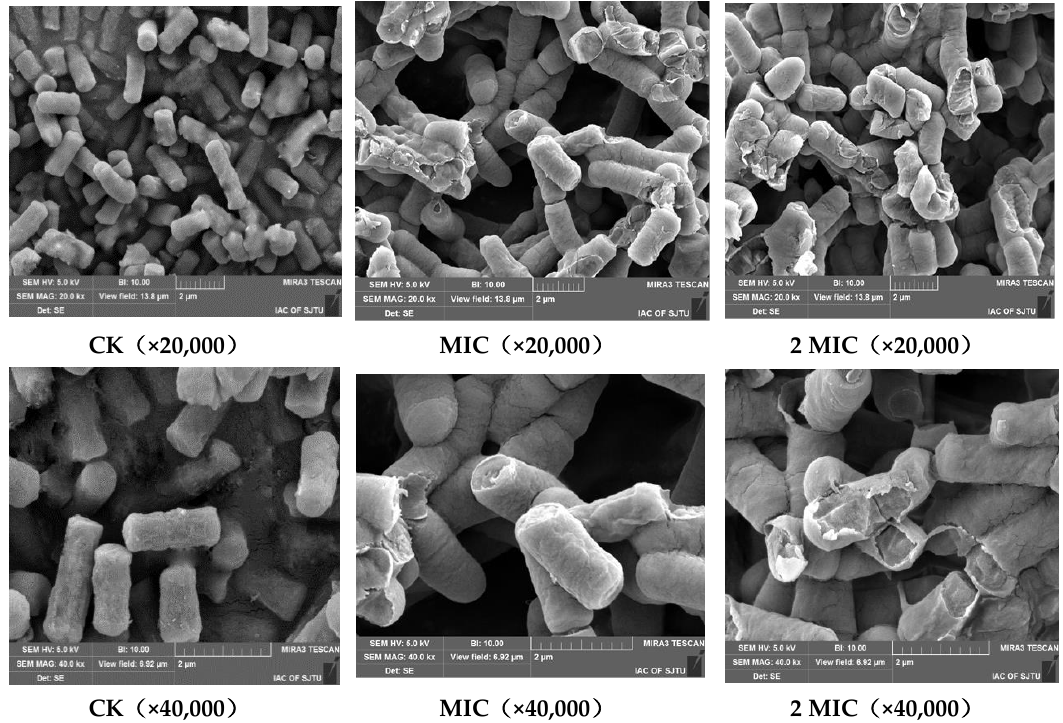
Figure 4. Scanning electron microscope (SEM) images of S. putrefaciens treated with sterile water (CK), 1 mg/mL ε-PL (1 MIC) and 2 mg/mL ε-PL (2 MIC).